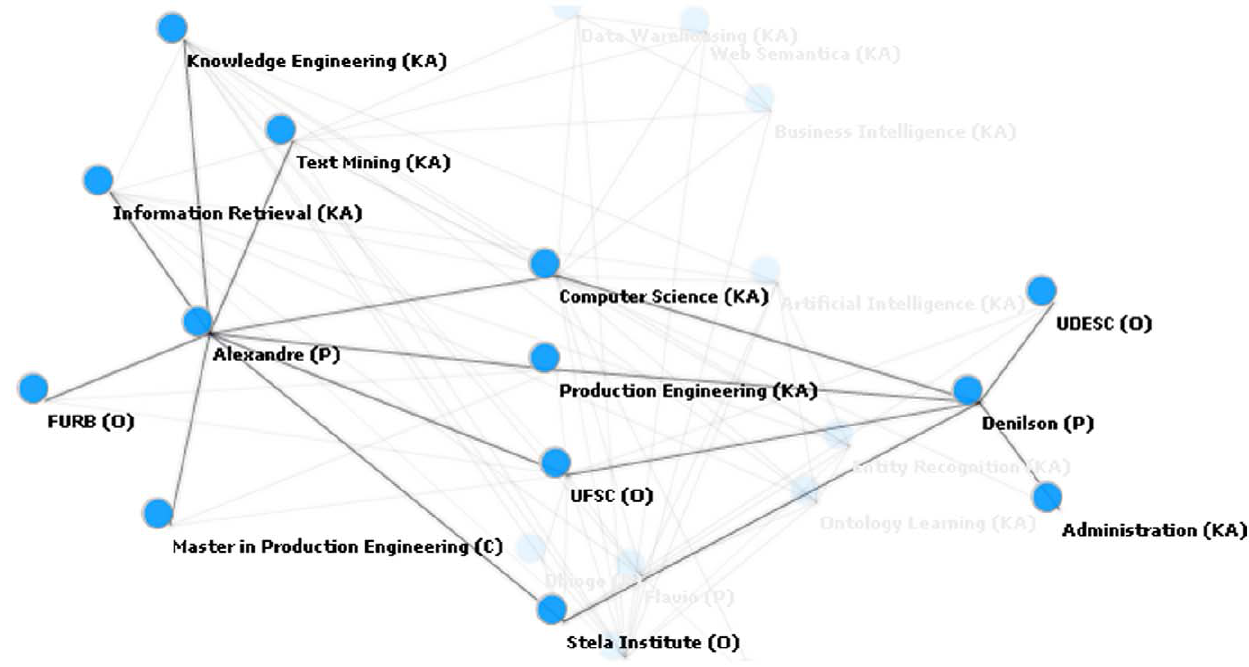
Figure 5. Relations between instances ‘‘denilson’’ and ‘‘alexandre’’.